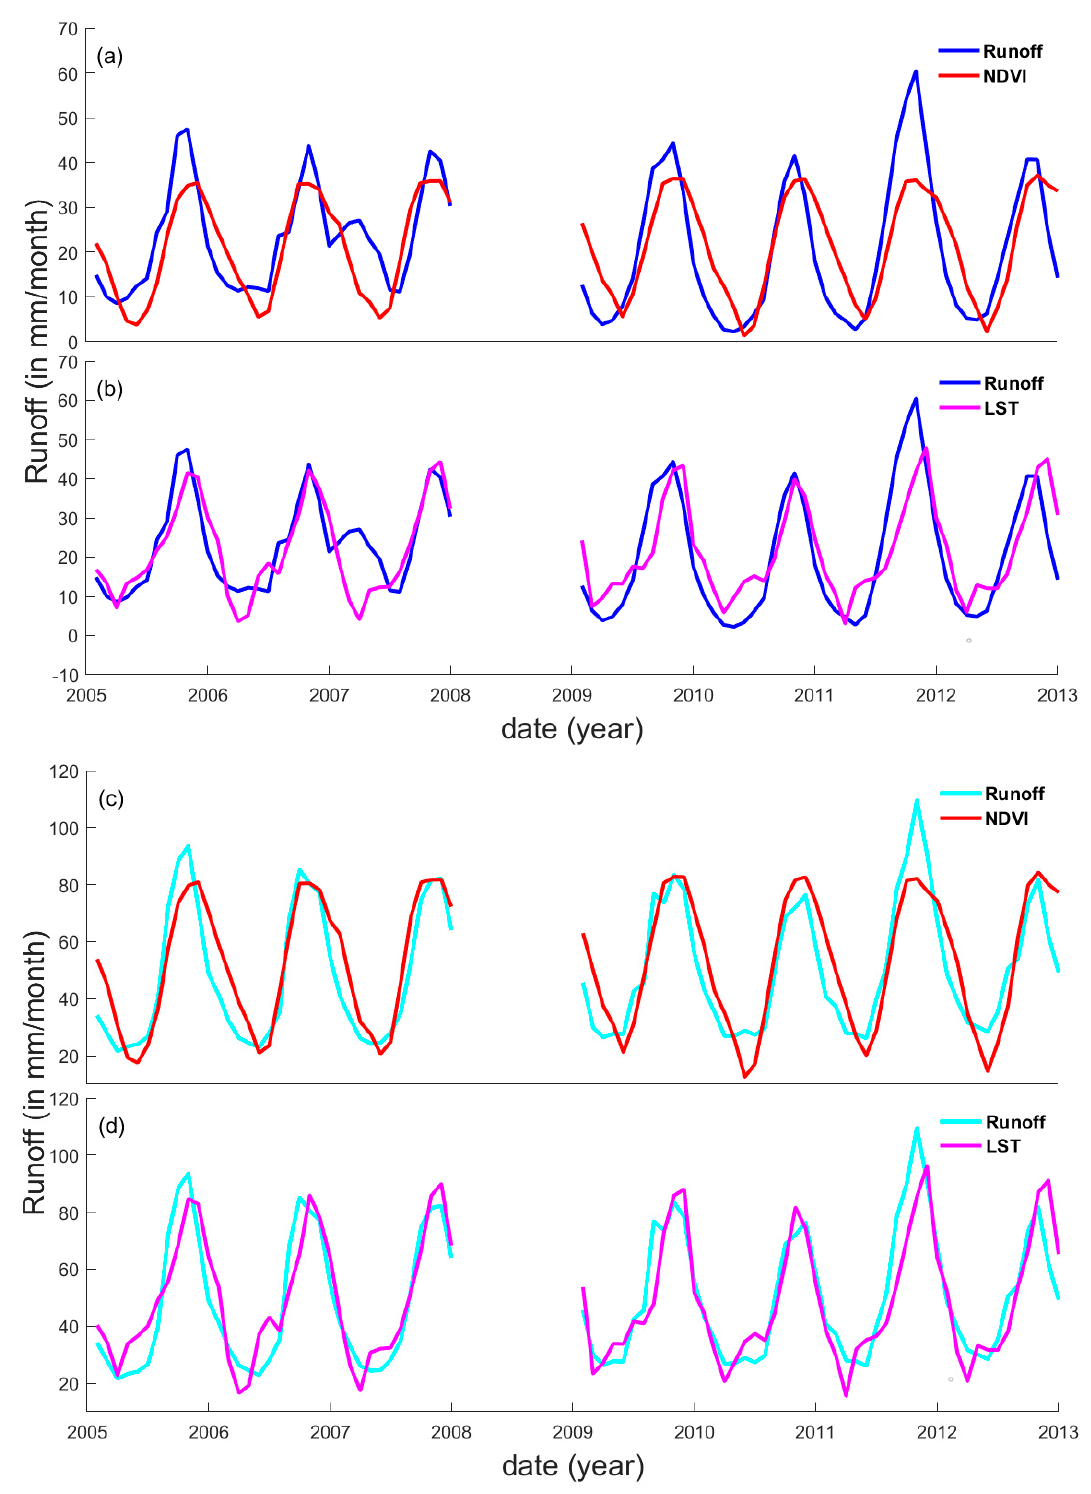
Figure 8. Reconstructed runoff estimates based on ( a ) and ( c ) Normalized Difference Vegetation Index (NDVI) and ( b ) and ( d ) Land Surface Temperature (LST), ( a ) and ( b ) My Thuan station, ( c ) and ( d ) Tan Chau station.